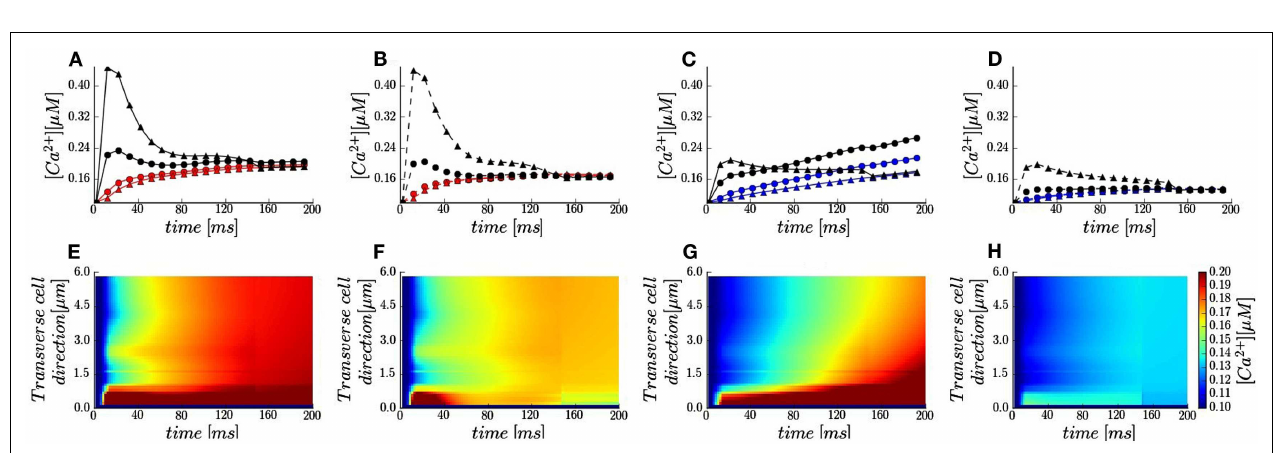
and black lines in (A,B) ] and at + 50mV [ blue and black lines in (C,D) ]. [Na + ] i 10mM ( solid lines ) and [Na + ] i 0mM ( dash lines ). (E–H) Calcium concentrations visualized as line-scan images in transverse cell direction for the cases described in (A–D) .